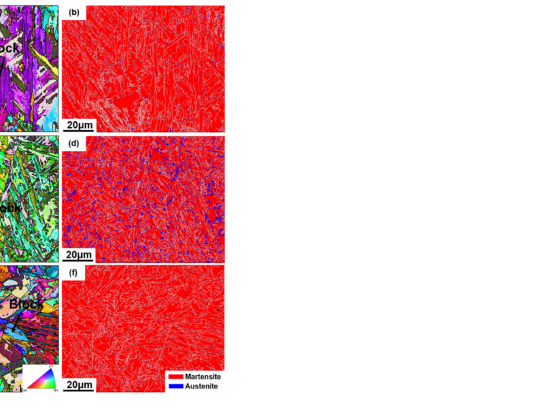
Figure 5. EBSD inverse pole figure maps of ( a ) AP, ( c ) AT and ( e ) SA samples, and the corresponding phase maps of ( b ) AP, ( d ) AT and ( f ) SA samples (white lines in phase maps represent grain